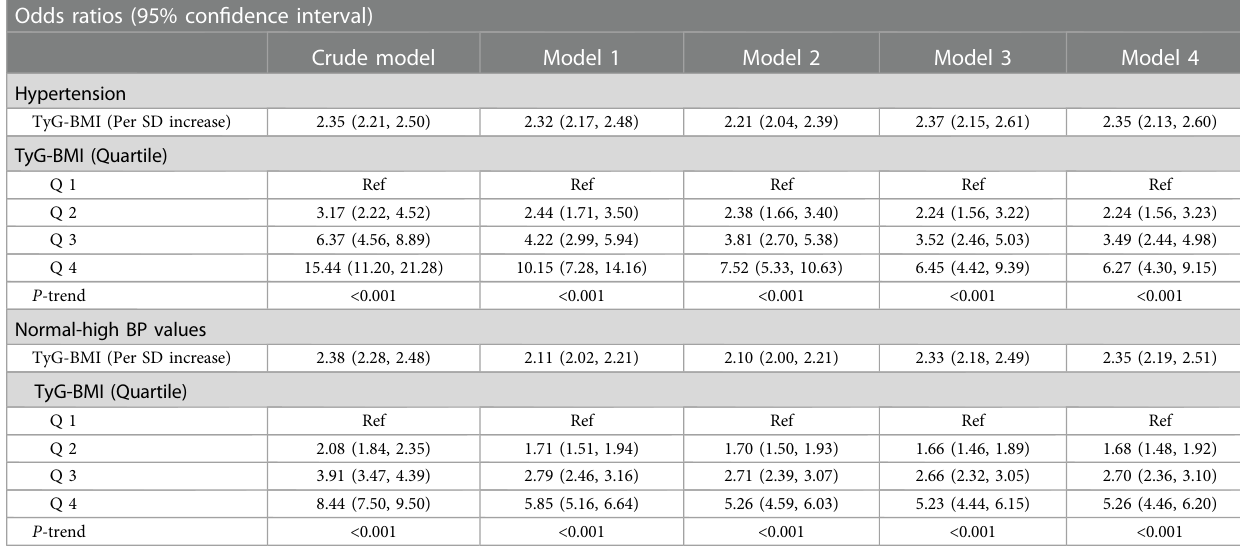
TABLE 2 Multivariable-adjust ORs and 95% CI of the TyG-BMI index quartiles associated with normal-high BP values and hypertension. Odds ratios (95% con fi dence